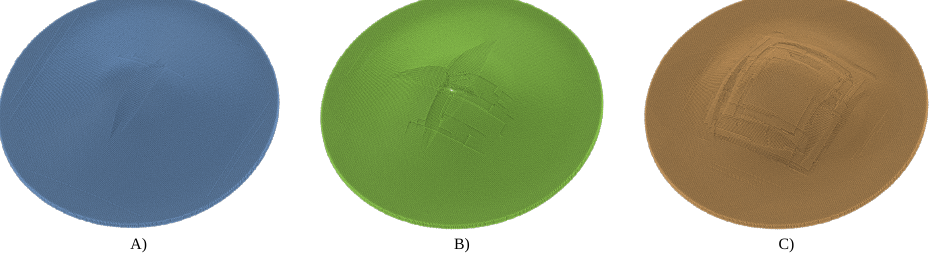
Figure 8. Failure patterns at different loading speeds: ( A ) 0.1Å/ps, ( B ) 0.8Å/ps, and ( C )